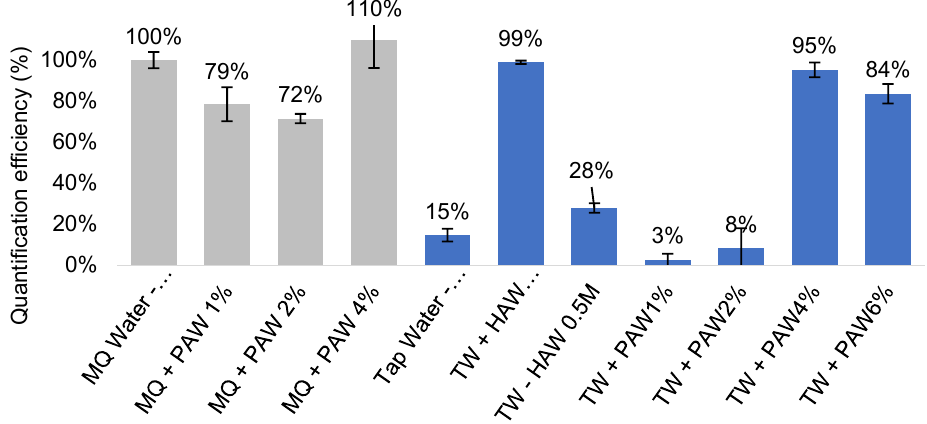
Figure 3. Effectiveness of inhibitor removal after various acid treatment in 50 mL filter-captured C. jejuni samples. PAW—phosphoric acid wash, filters treated with 10 mL of 1–6% phosphoric acid after capture. HAW—hydrochloric acid wash, filters treated with 10 mL of 0.5 M hydrochloric acid after capture. Grey columns—control samples with Milli-Q water (MQ) to assess effect of acid treatment on filters alone. Blue columns—quantification performed in spiked tap water (TW) samples.